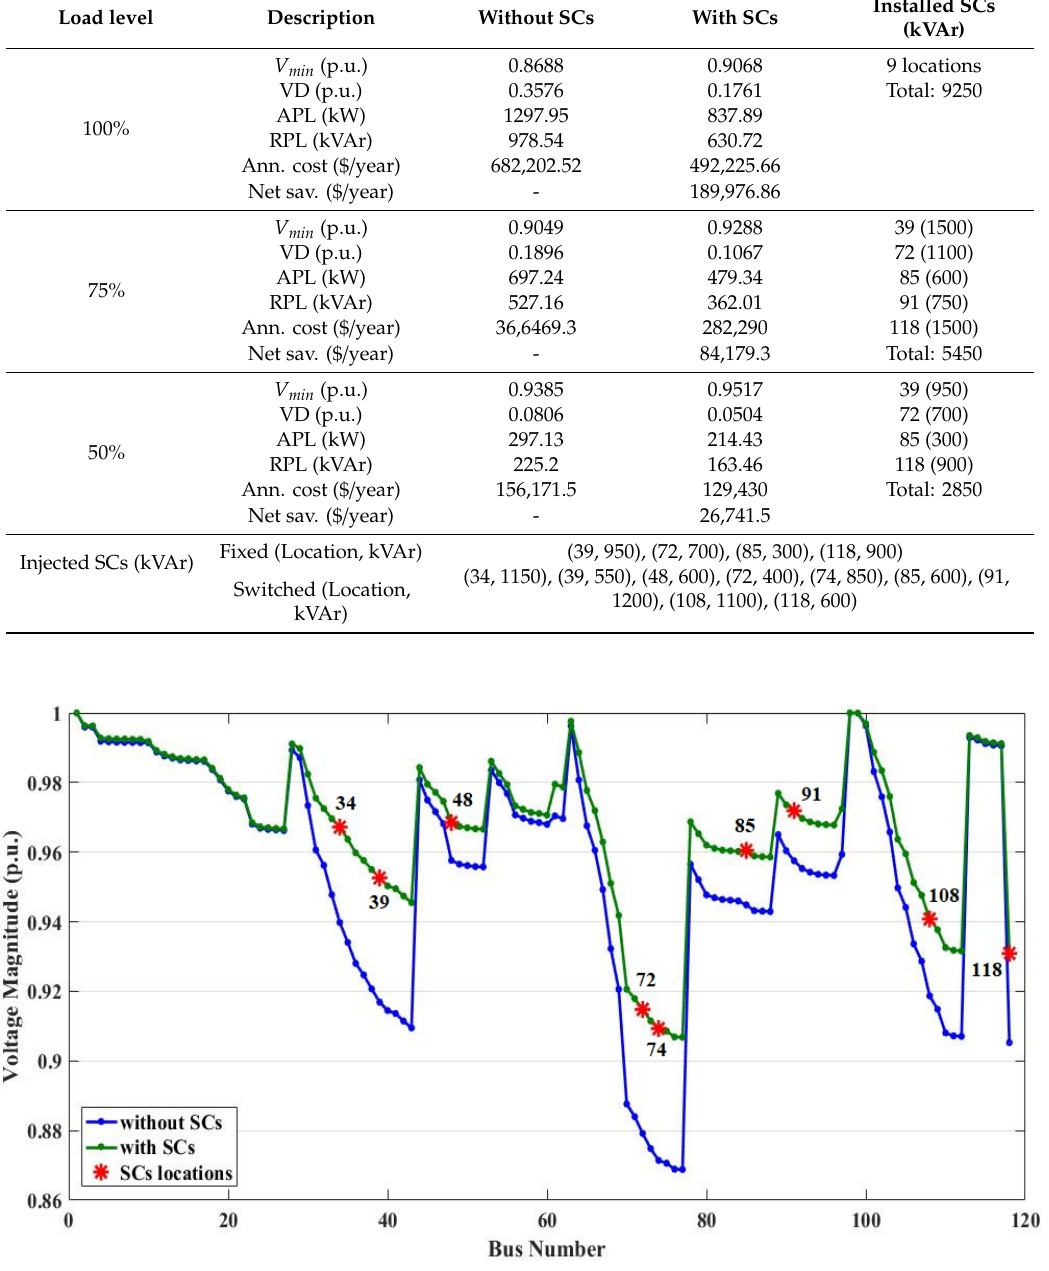
Figure 8. Voltage profile of the 118-bus system considering full-load level using PODESCA and SBDMT. Table 16. Optimal results of PODESCA and SBDMT for the 118-bus system considering different load levels.